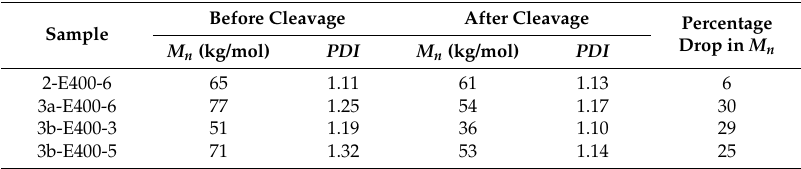
Table 4. Effect of cleavage on polymer molecular weight and distribution a